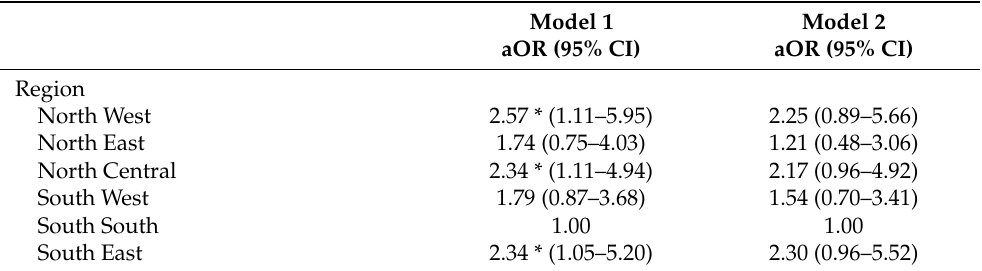
Table 2. Logistic regression showing adjusted odds of an HCW getting two doses of a COVID- 19